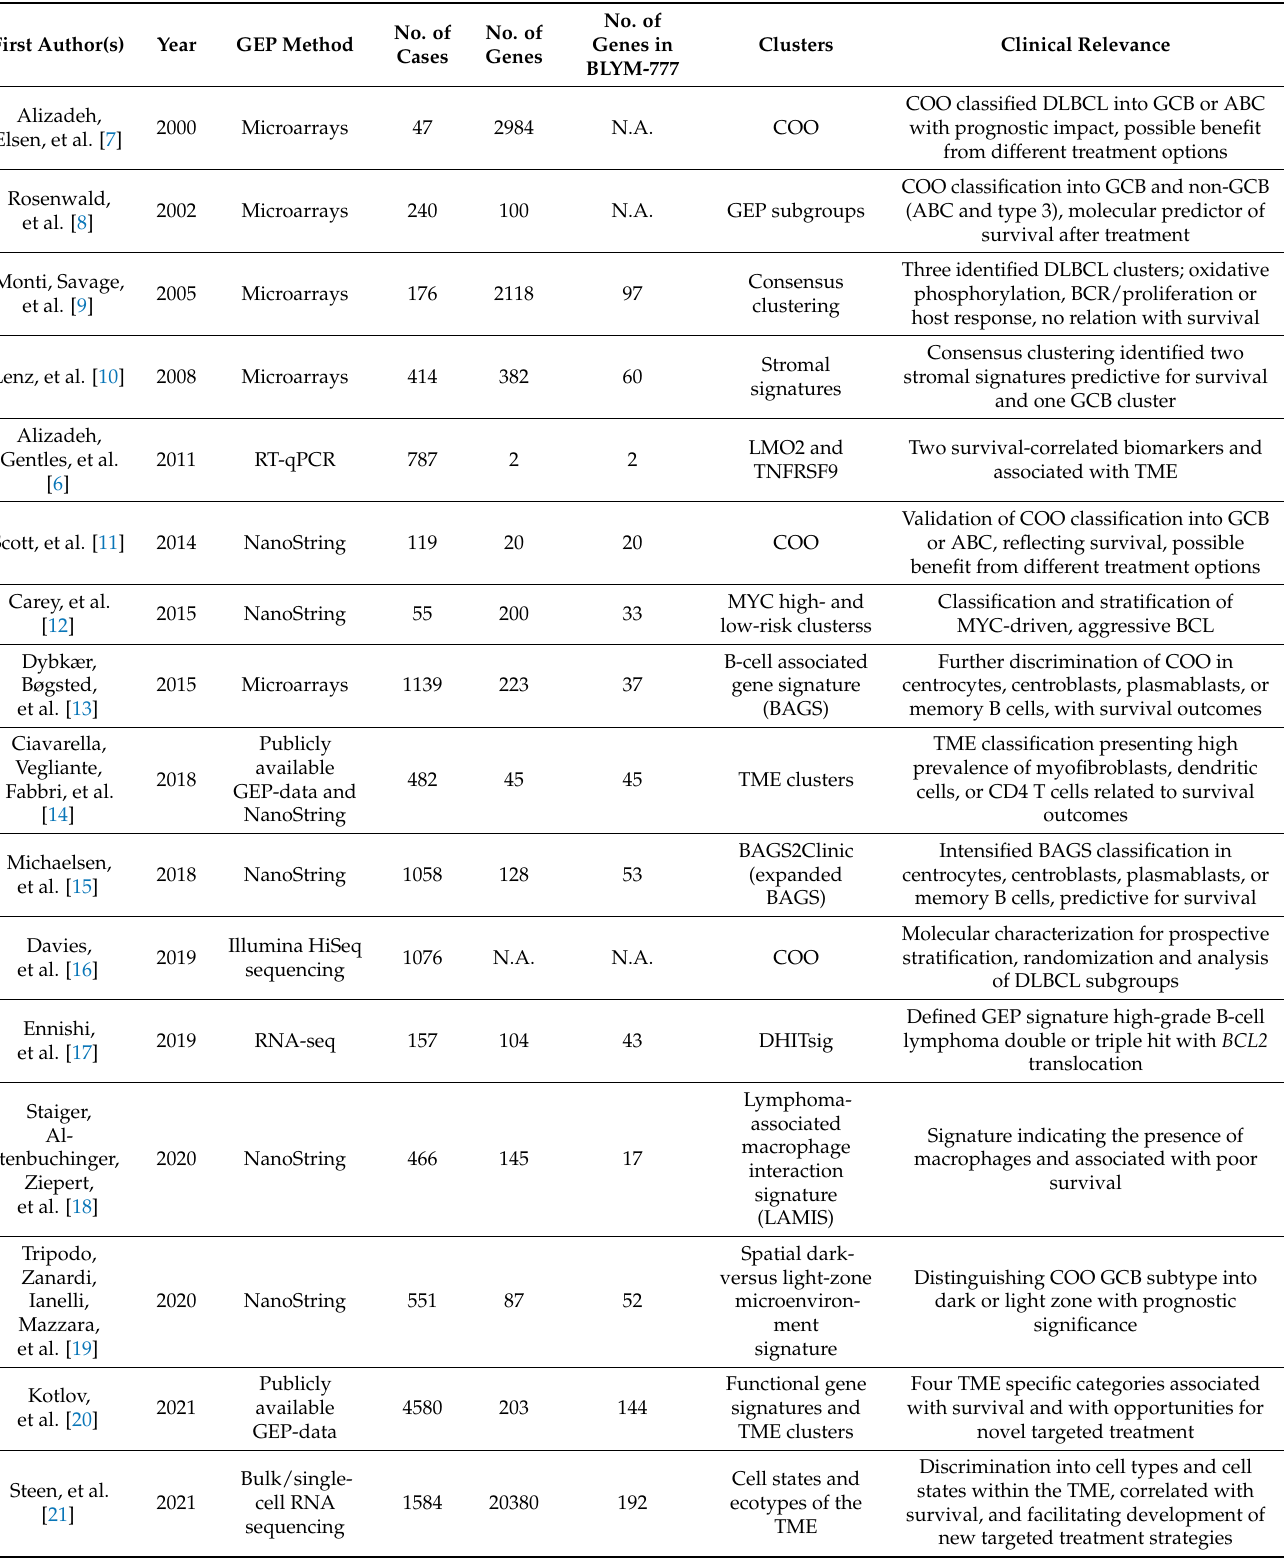
Table 1. Literature overview of relevant DLBCL studies with their respective GEP methods, number of included cases and genes, cluster targets and clinical relevance. COO = cell-of-origin, TME = tumor microenvironment, N.A. = not available, complete gene lists of these studies were not